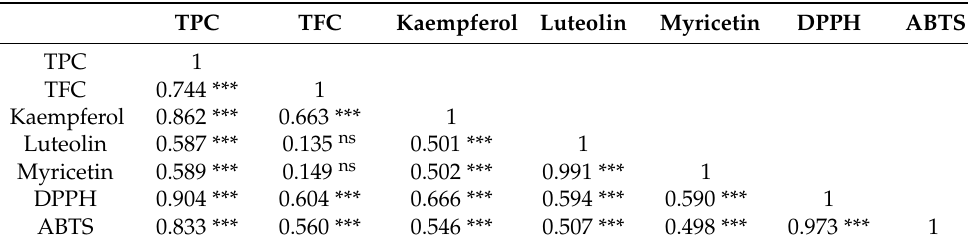
Table 4. Correlation coefficient analysis between polyphenols, and antioxidant activities in three cultivars of lentil during thermal processing. TPC TFC Kaempferol Luteolin Myricetin DPPH ABTS TPC 1 TFC 0.744 *** 1 Kaempferol 0.862 *** 0.663 *** 1 Luteolin 0.587 *** 0.135